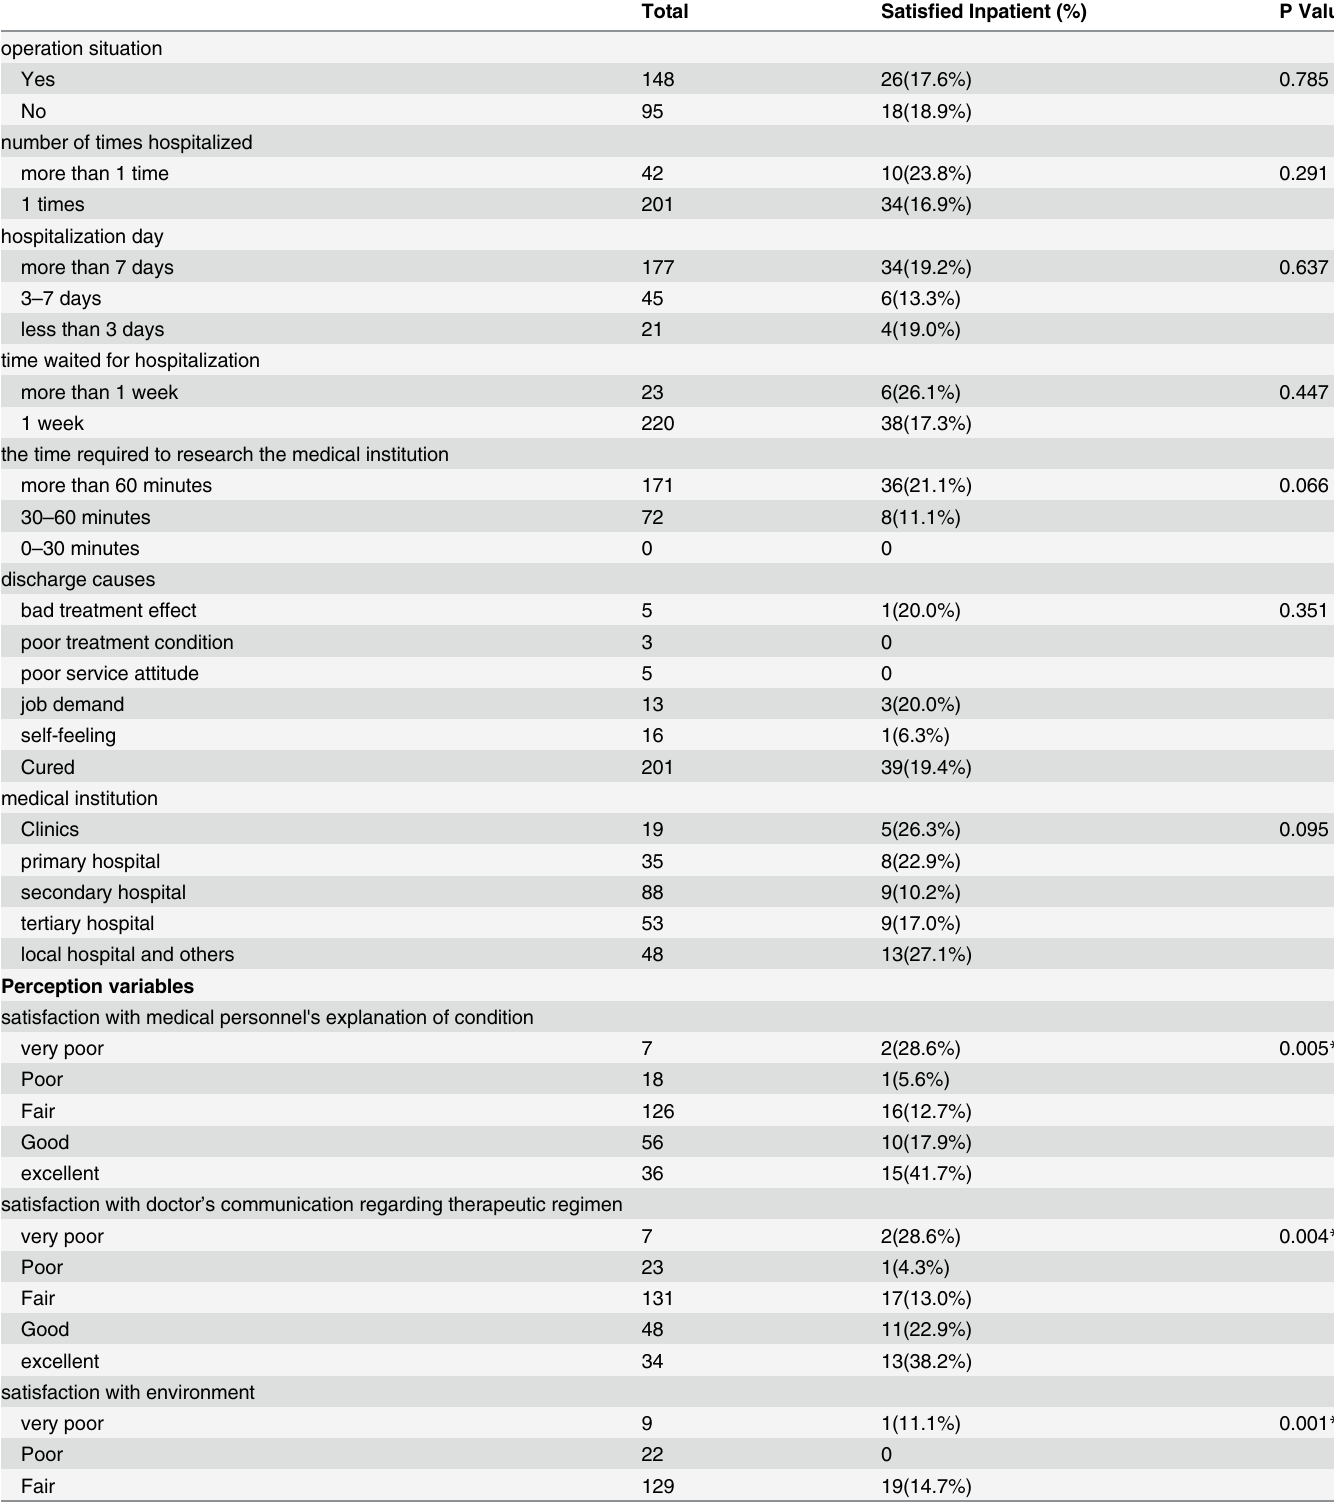
Table 3. The relationship between soldiers satisfaction and the hospitalizations aspect, received inpatient care and perception